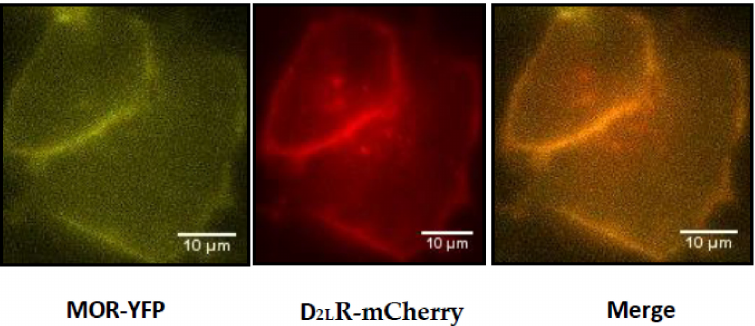
Figure 2. Localization analysis of the tagged receptors in live cells. HeLa cells were transiently transfected with pMOR-YFP (yellow) and pD 2L R-mCherry (red) and subsequently (48 h post-transfection), their localization was examined by epifluorescence microscopy.